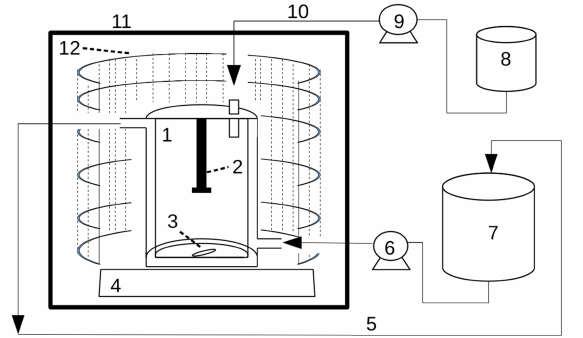
Figure 1. Diagram of the photo-Fenton reaction system: (1) reactor, (2) dissolved oxygen sensor, (3) magnetic stirrer, (4) stirring plate, (5) water recirculation, (6) water pump, (7) water container, (8) peroxide container, (9) H 2 O 2 pump, (10) H 2 O 2 input, (11) wood box, (12) circular LED